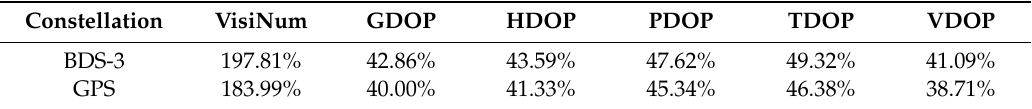
Table 9. Global average visible satellites and dilution of precision (DOP) values improving rates of BDS-3 + HEO + LEO relative to BDS-3 and